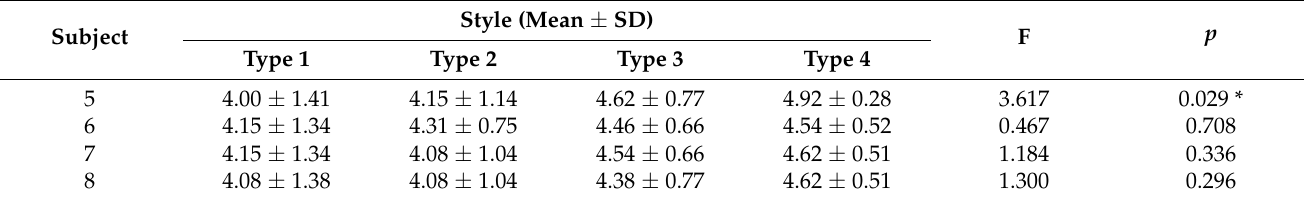
Table 19. Welch variance analysis of user’s subjective preference data with different styles of keys.